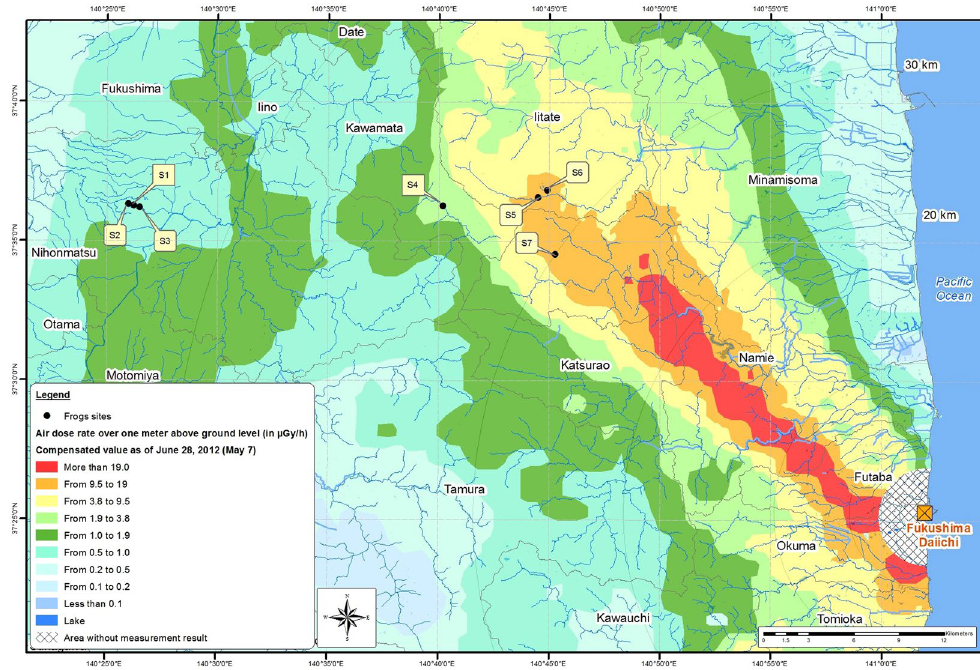
Figure 1. Map of ambient dose rate ( µ Gy/h) in the Fukushima area and location of the seven sampling sites (S1–S7). The map was created by JM Métivier with ArcGis 10.3.1.